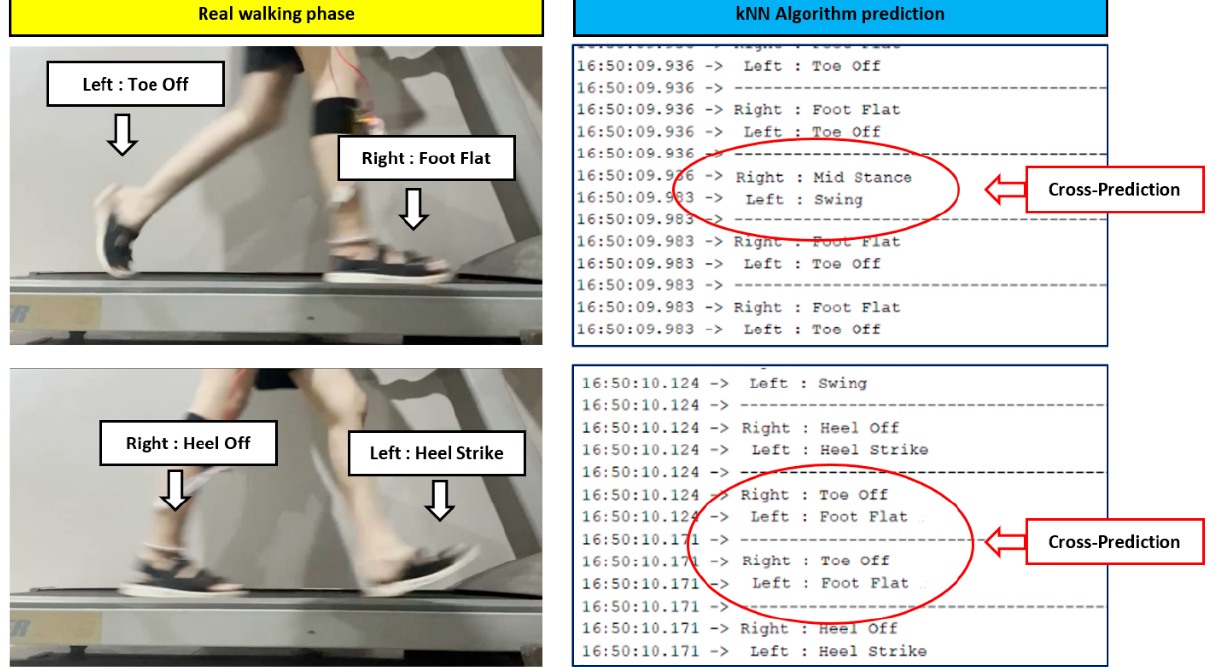
Figure 8. Cross-phase prediction of walking speed at 6 km/h. For the real-time implementation—controlling a transtibial prosthesis—two esp- wroom 32 microcontroller boards were used. One was attached to the leg with a wearable